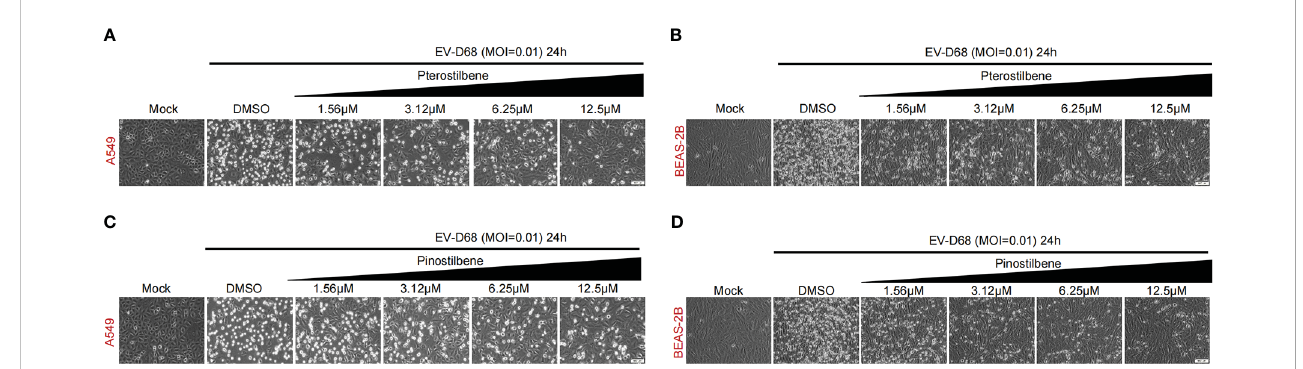
FIGURE 2 Pterostilbene (Pte) and pinostilbene (Pin) relieve CPEs in EV-D68-infected respiratory cells. (A, B) Indicated cells were pre-treated with increasing concentrations of Pte or DMSO vehicle before infection or mock-infection with EV-D68 virus. CPEs were observed 24 h post-infection. (C, D) Indicated cells were pre-treated with increasing concentrations of Pin or DMSO vehicle before infection or mock-infection with EV-D68 virus. CPEs were observed 24 h post-infection. EV-D68, Enterovirus D68; DMSO, dimethyl sulfoxide; CPE, cytopathic effects.